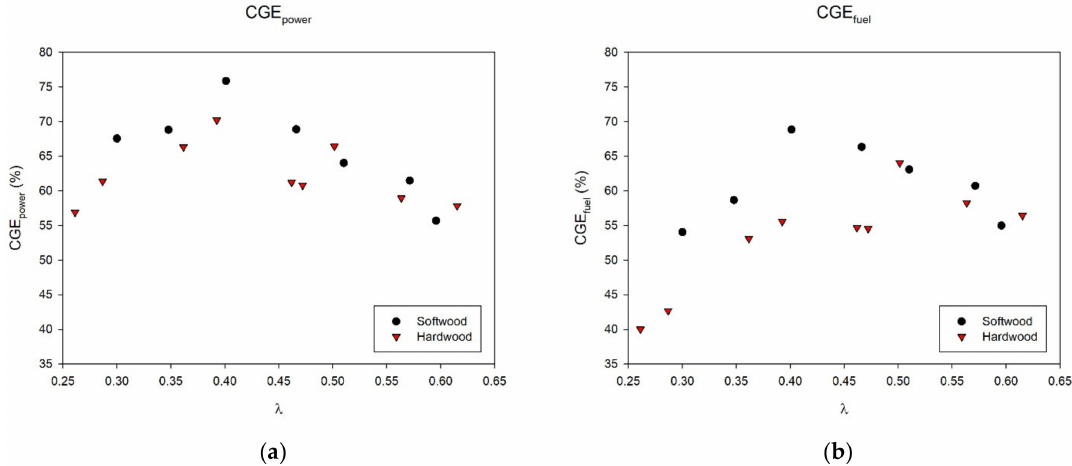
Figure 5. Cold gas efficiencies (CGE) as a function of λ , ( a ) CGE power and ( b ) CGE fuel